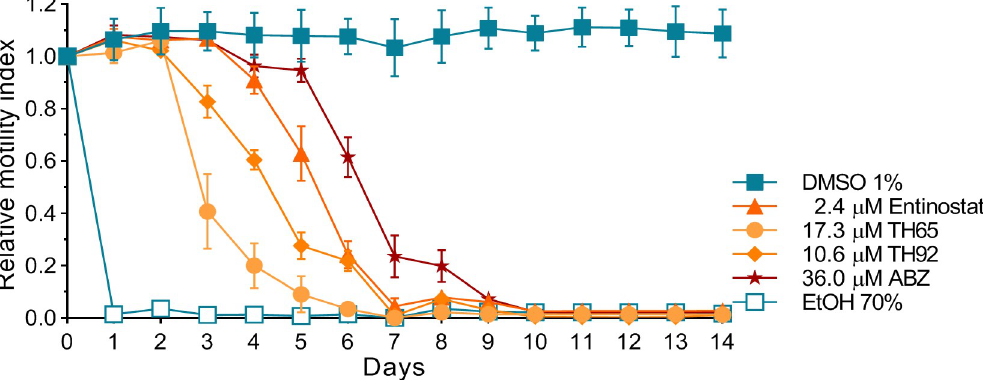
Fig 4. Reversibility in vitro test of selected HDAC inhibitors and albendazole (ABZ). In vitro anthelmintic activity was determined for entinostat, TH65, TH92, and ABZ at different incubation times, using the Mesocestoides vogae TTy (tetrathyridia) motility assay. Relative motility indices were measured from three independent biological replicates, each one in quadruplicate. Error bars represent the standard deviation. The compounds were tested at their respective IC 90 concentrations for 6 days, then culture medium was removed, and TTy were gently washed and incubated with a fresh culture medium without adding the compounds for 8 additional days. Parasites incubated with the drug vehicle (1% DMSO) were used as a negative